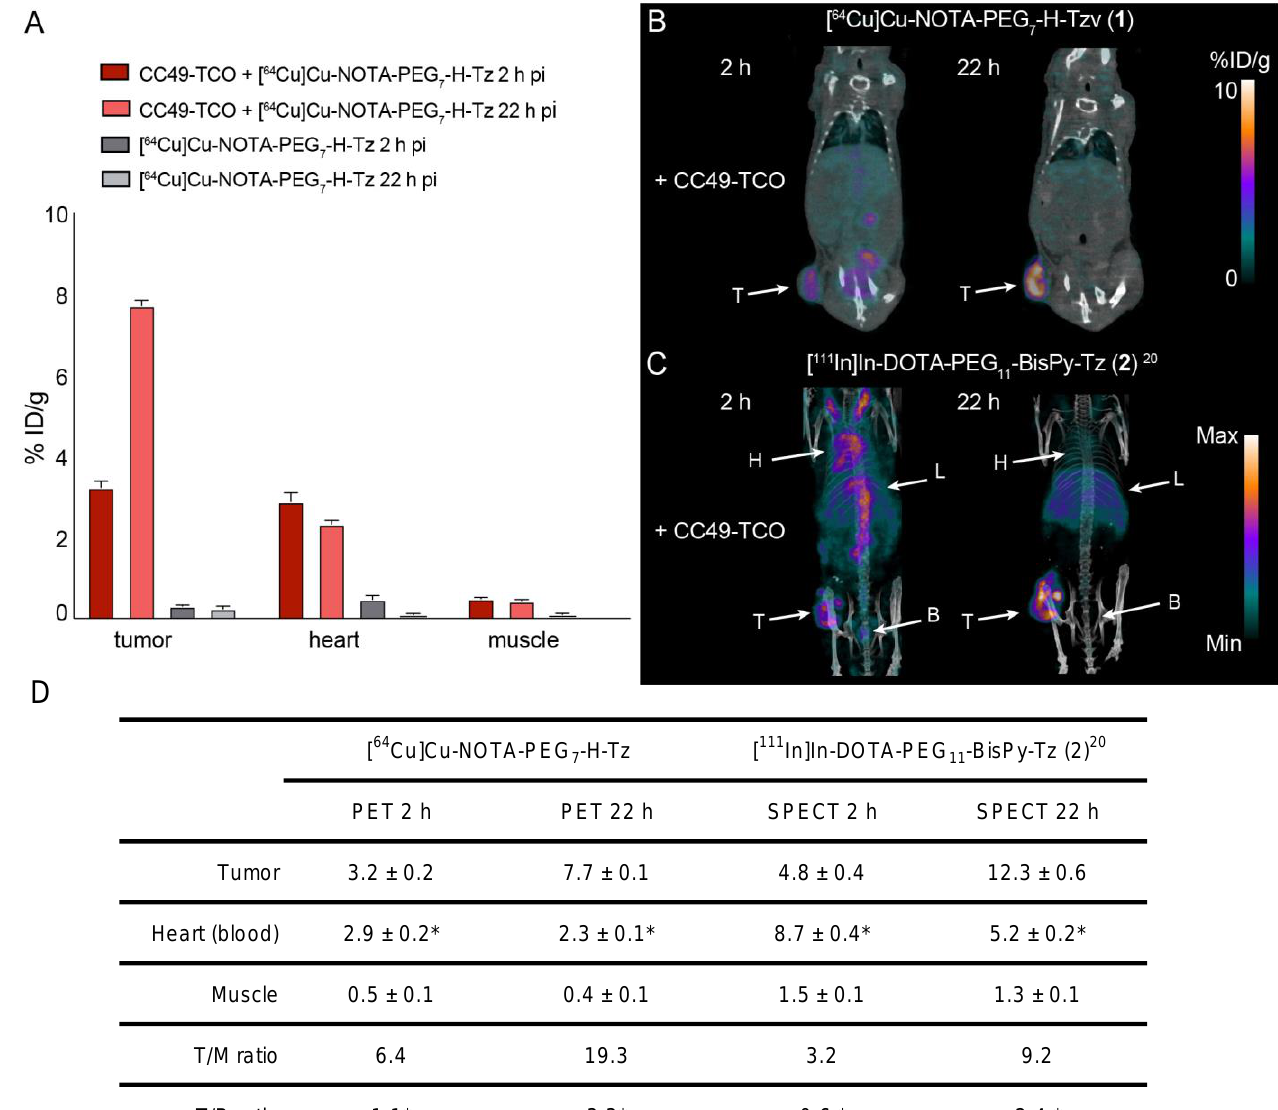
Figure 3. Pretargeted PET/CT imaging. ( A ) PET image-derived mean tissue uptake values in % ID/g (mean ± SEM, n = 4). ( B ) PET images of [ 64 Cu]Cu-NOTA-PEG 7 -H-Tz ( 1 ) (in mice bearing colon carcinoma LS174T xenografts). The mice were pretreated with CC49-TCO 72 h prior to injection of [ 64 Cu]Cu-NOTA-PEG 7 -H-Tz ( 1 ). Imaging was performed 2 and 22 h post injection. T: Tumor. ( C ) Data adopted from reference [11]. Maximum intensity projections from SPECT/CT scans of [ 111 In]In-DOTA-PEG 11 -BisPy-Tz ( 2 ) in mice bearing colon carcinoma LS174T xenografts and pretreated with CC49-TCO 72 h prior to injection of the tracer. T: tumor, B: bladder, L: lungs, H: heart. ( D ) Image-derived mean uptake values (% ID/g), tumor-to-muscle (T/M) ratios and tumor-to-blood (T/B) ratios from [ 64 Cu]Cu-NOTA-PEG 7 -H-Tz ( 1 ) PET scans at 2 h and 22 h p.i. in nude BALB/c mice bearing subcutaneous LS174T tumor xenografts pretreated with CC40-TCO ( n = 4). For comparison, data from [ 111 In]In-DOTA-PEG 11 -BisPy-Tz ( 2 ) previously obtained are also included ( n =3). 20 Data are shown as mean ± standard error of mean (SEM). * Image-derived uptake in heart from SPECT and PET images used as a surrogate for blood.